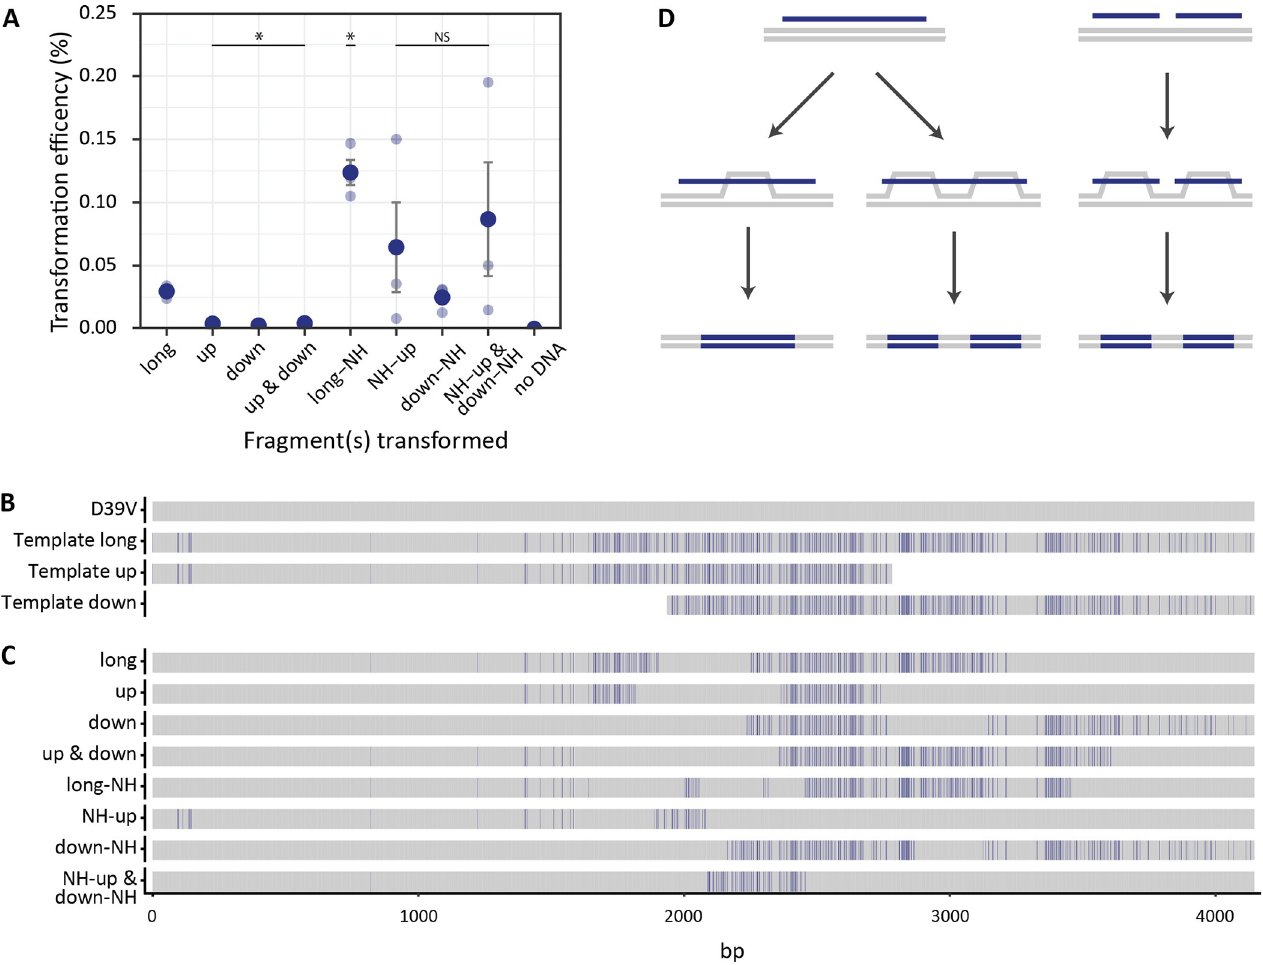
Fig 6. Fragmented transformation of donor DNA predominantly originates from non-contiguous recombination events. Three fragments were PCR amplified from the 11A strain pbp2x locus, one long 4.2 Kb fragment, and two overlapping short fragments (up 2837 bp, and down 2260 bp). In addition, the same fragments were ligated to stretches of non-homologous DNA, taking all total lengths to 6 Kb (long-NH, NH-up, and down-NH). (A) Efficiencies of transformation of fragments into D39V with selection on AMX (0.015 μ g/mL). Statistically significant differences in efficiency compared to the long fragment was determined by t test with BH correction for multiple testing. NS not significant, � indicates p < 0.05. (B) Alignment of the homologous region of template fragments used in the experiment. Donor SNPs are shown in blue, while bases matching the recipient (D39V) are shown in grey. (C) Alignment of 4.2 Kb locus from colonies transformed with different fragments. Bases shared with donor but not with recipient are shown in blue. (D) Schematic showing hypothesized molecular mechanisms for non-contiguous and contiguous recombination. As shown in panel B, both events can take place, but based on transformation efficiencies, the process on the left with long donor DNA is more